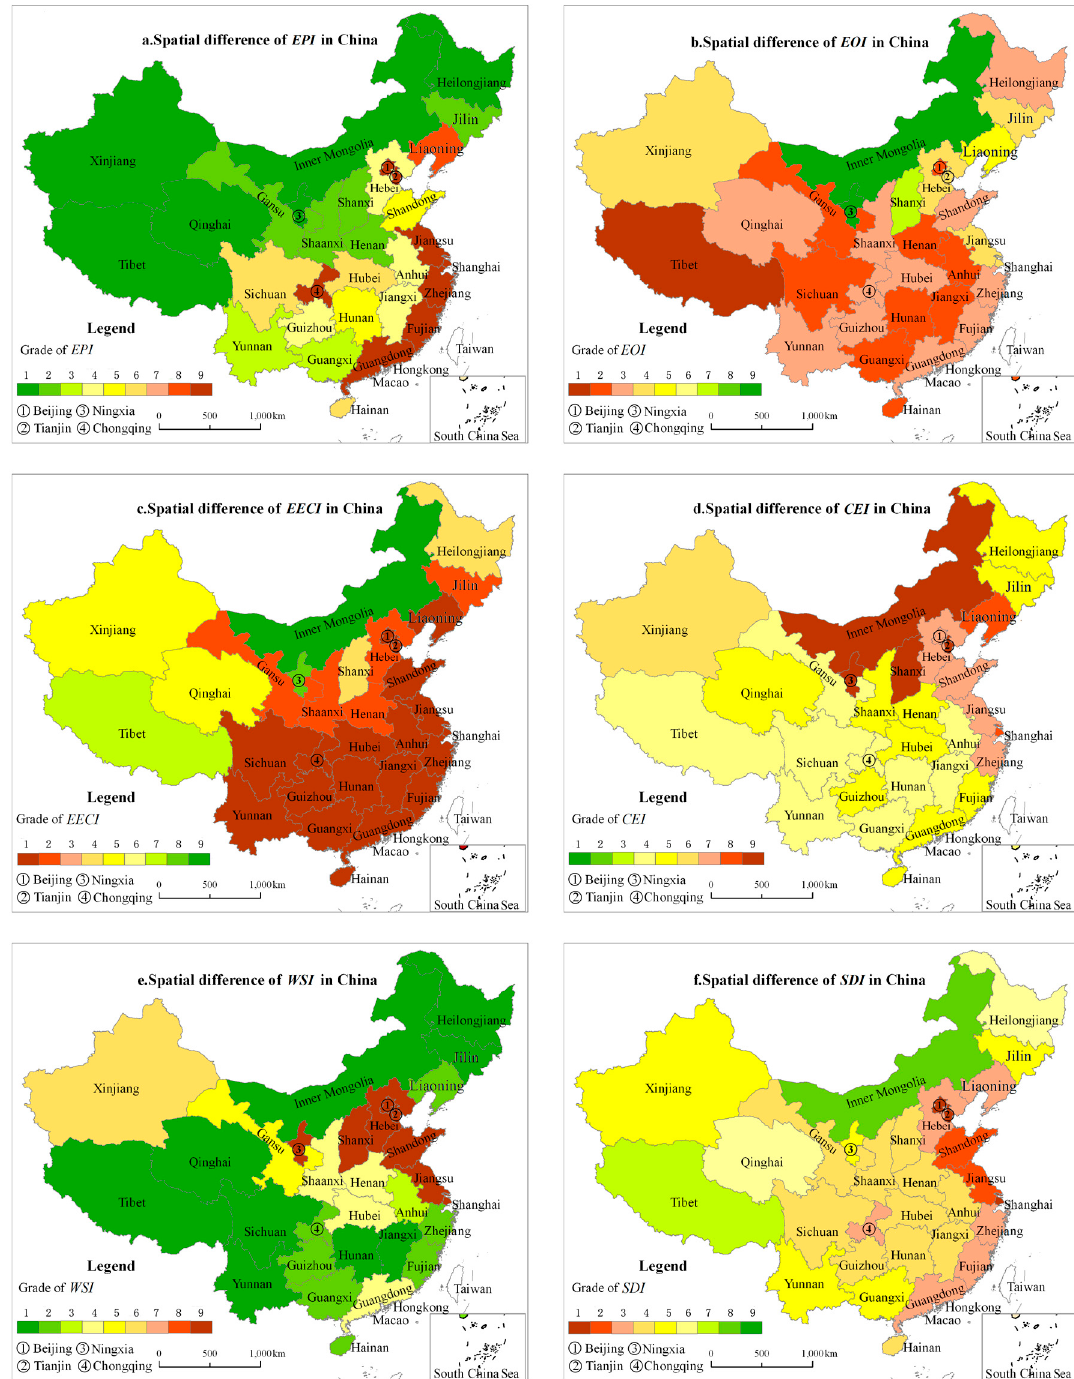
Figure 9. Spatial pattern of the sustainable development index.